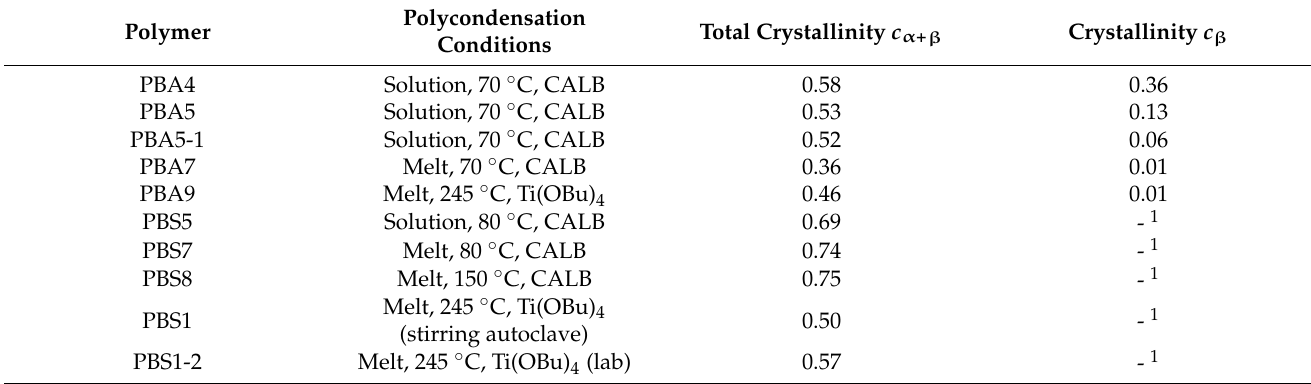
Table 3. X-ray crystallinities for selected PBA and PBS samples obtained by enzymatic polycondensation with CALB in solution and in